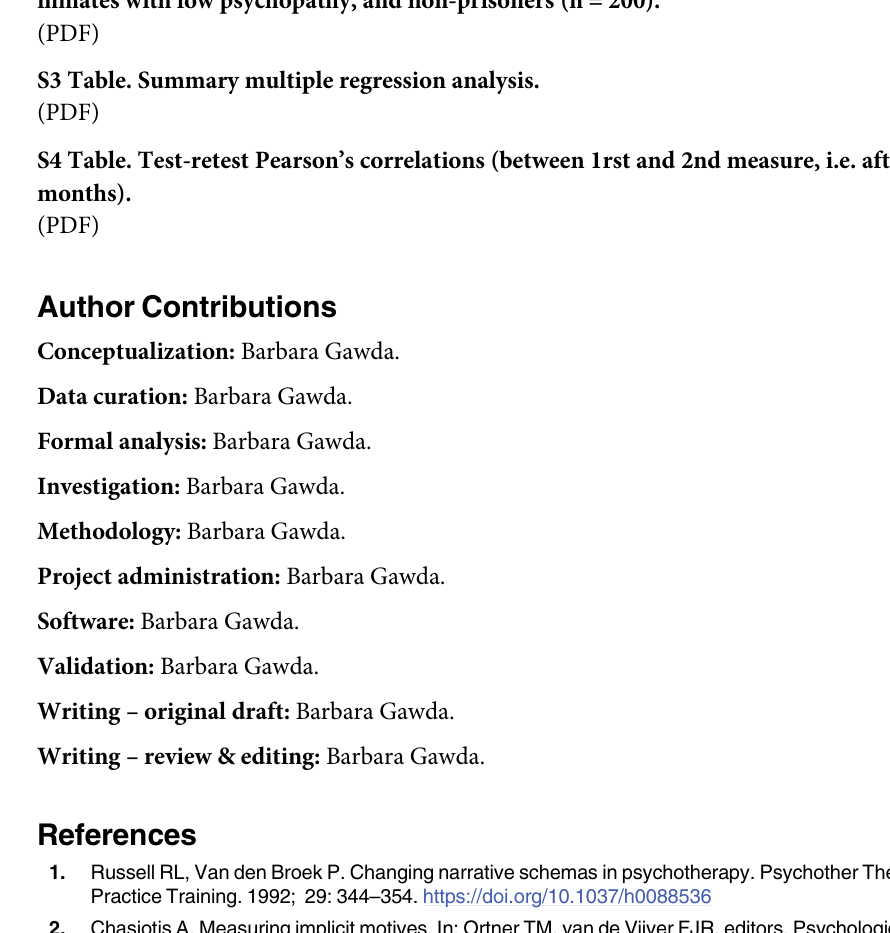
S1 Table. Inter-rater correlations (the intra-class correlations between three independent coders). S2 Table. Intergroup comparisons between inmates with high Psychopathy (Psych), inmates with low psychopathy, and non-prisoners (n = 200). S3 Table. Summary multiple regression analysis. S4 Table. Test-retest Pearson’s correlations (between 1rst and 2nd measure, i.e. after four